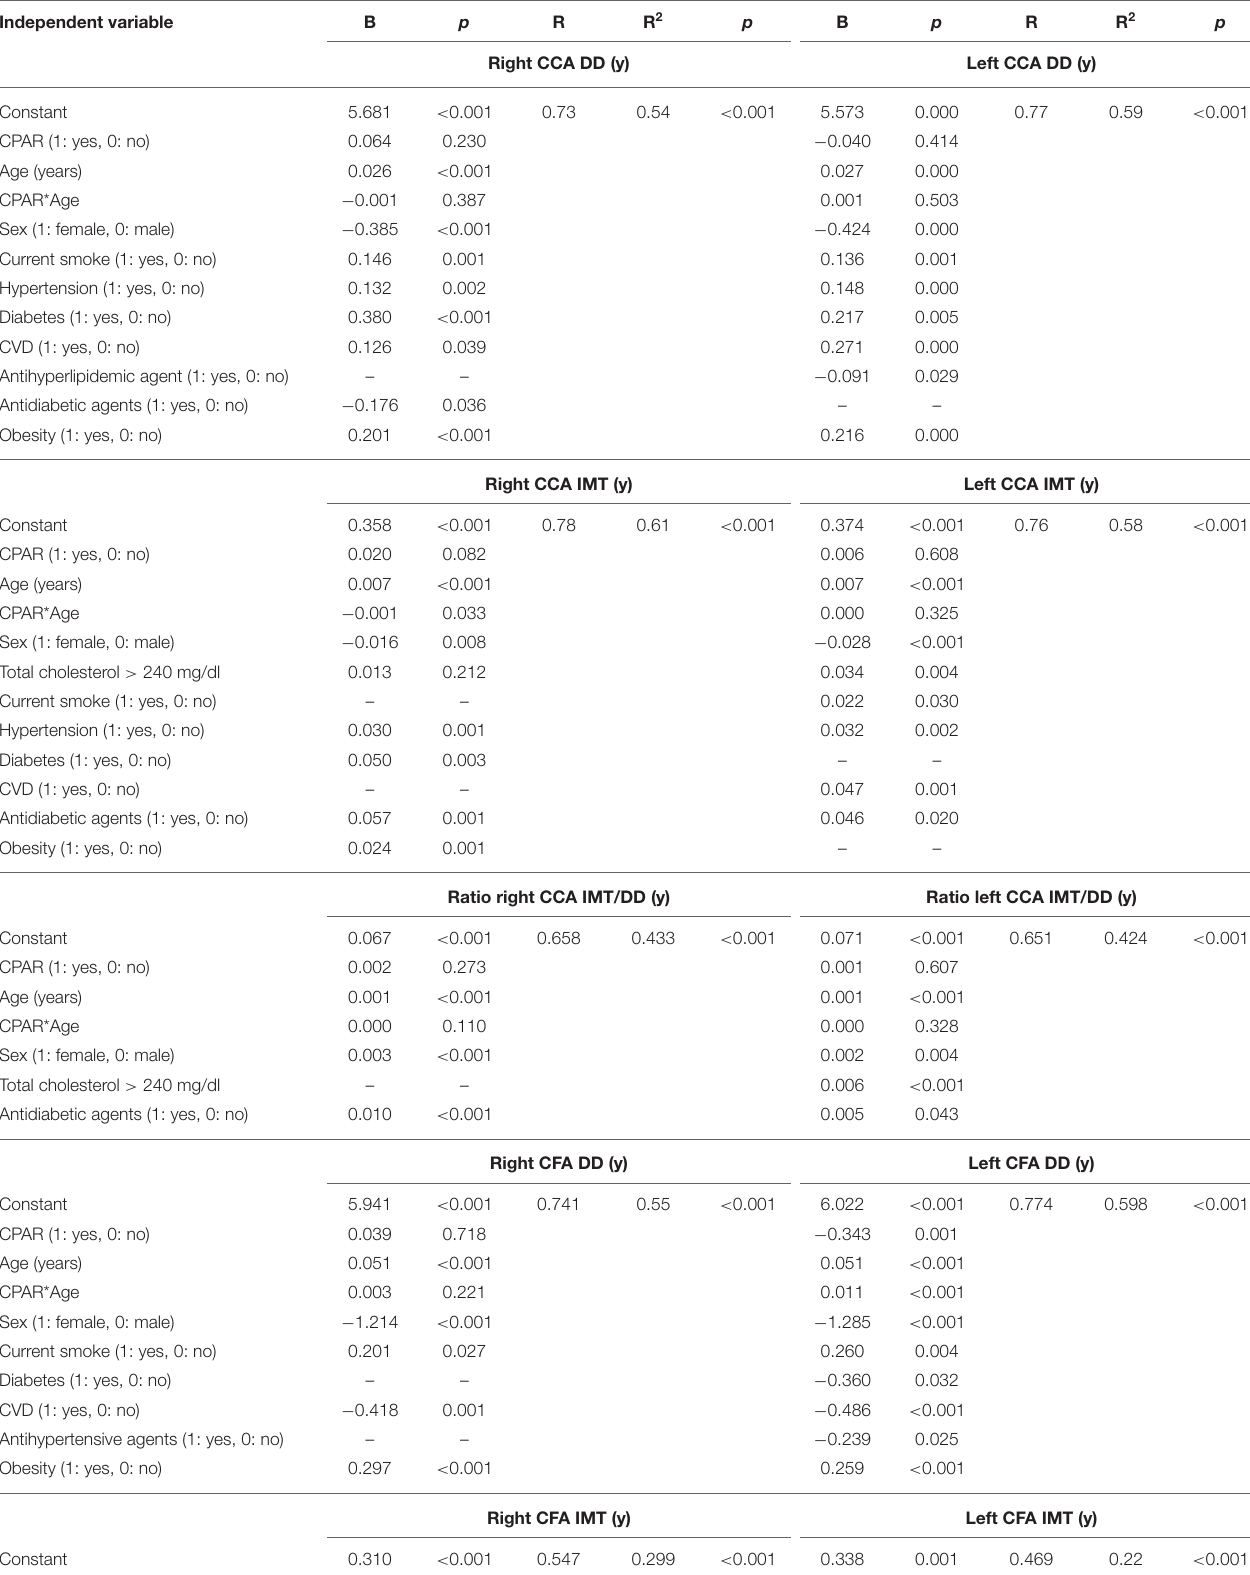
TABLE 9 | Association between CPARs and arterial structural parameters, with age as a moderating variable. Independent